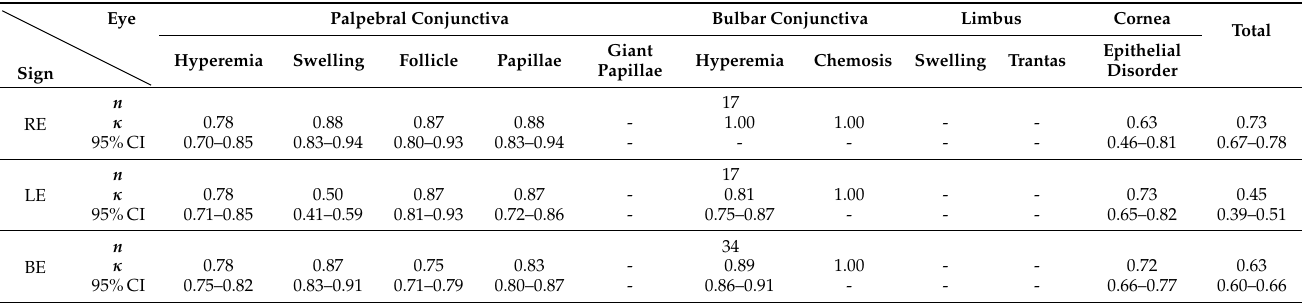
Table 2. Reproducibility of the ACD scores evaluated by the two